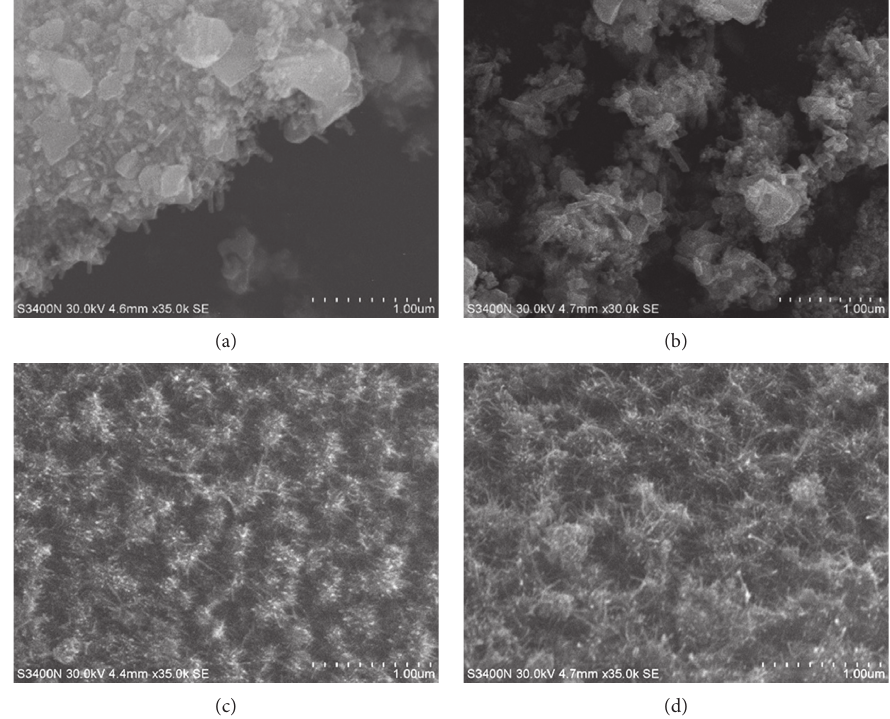
Figure 4: The SEM images of investigated SnO